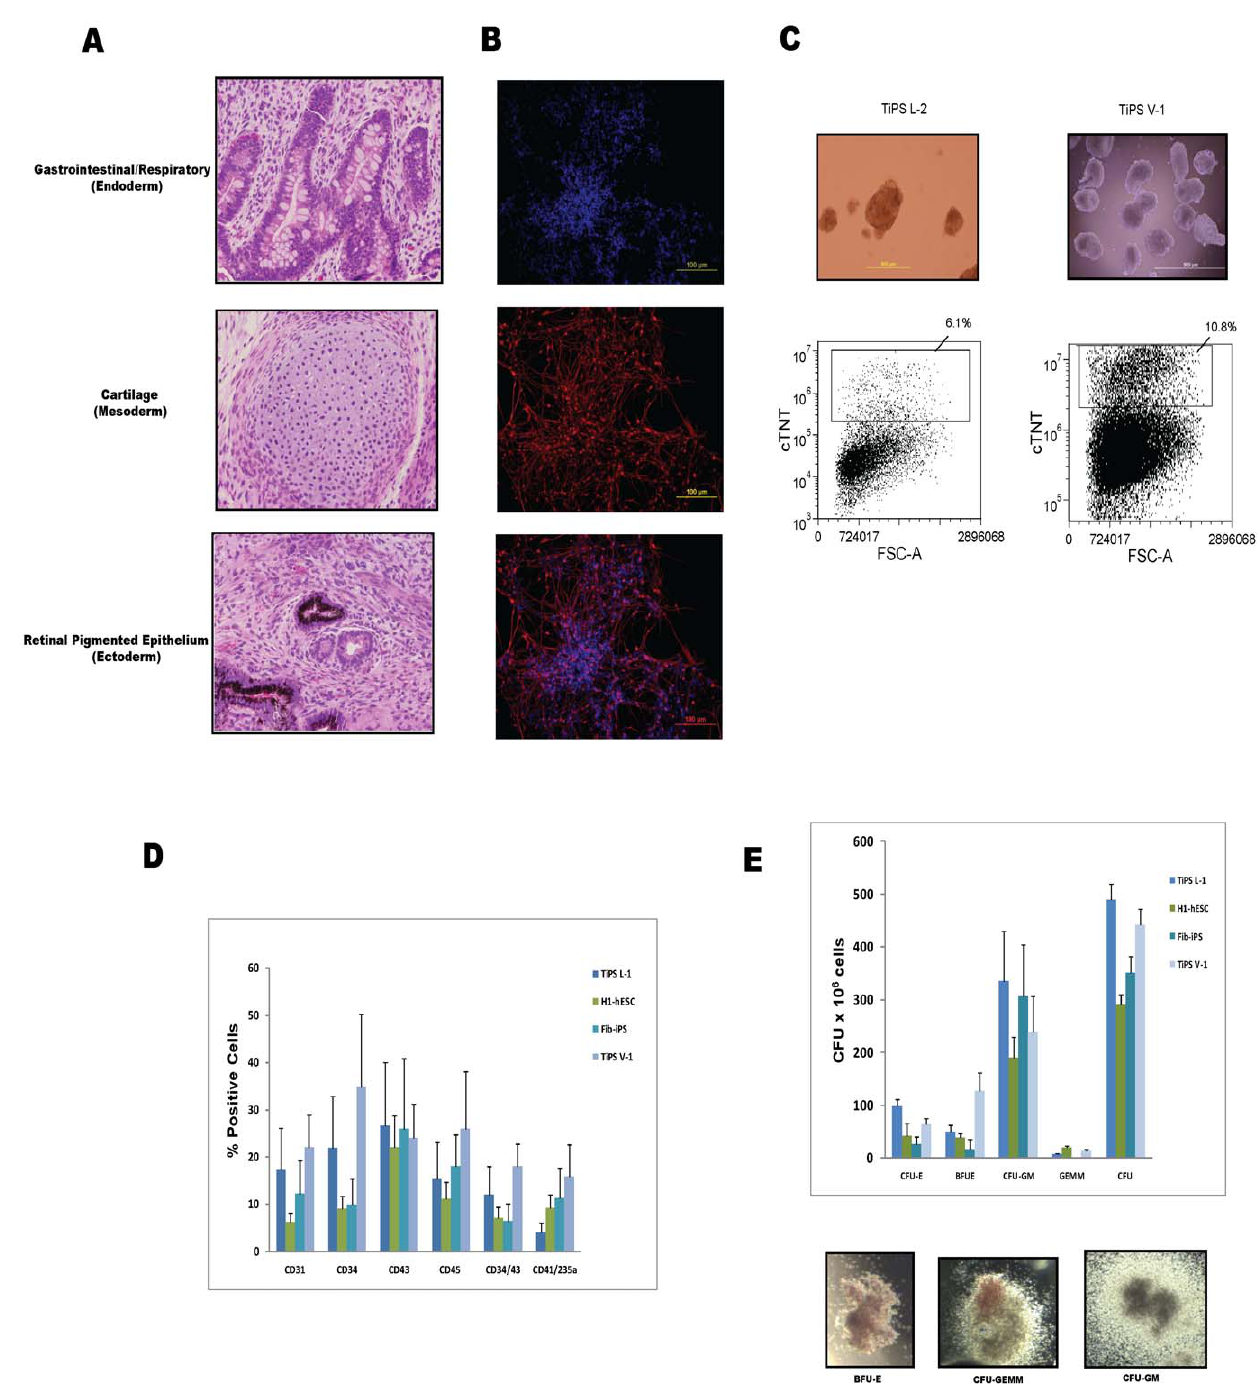
Figure 4. Invivo and invitro differentiation potential of TiPS cell lines. (A) Teratoma formation shows in vivo differentiation potential. TiPS cells injected into SCID/beige mice formed teratomas at 5 to 12 weeks. Hematoxylin and eosin staining shows tissues consistent with derivation from the three primary germ layers including simple epithelium with goblet cells indicating gastrointestinal or respiratory tissue (endoderm), cartilage (mesoderm) and retinal pigmented epithelium (ectoderm). Representative images from TiPS L-2 cell line were acquired using an Olympus IX71 microscope using a 40 6 objective. (B) In vitro differentiation into neurons. TiPS L-2 cells were induced into neuronal differentiation as aggregates then stained for neuronal marker beta III-tubulin with an Alexa Fluor 594 secondary antibody; cell nuclei were counterstained with Hoechst stain. Images were acquired using a 20 6 objective. Contrast was adjusted and images were merged using Image J software. (C) Cardiac induction of TiPS cells via cell aggregate method. Cell aggregates contain beating cardiac troponin T (cTNT)-positive cardiomyocytes at days 14 to 15. Flow data from representative samples is shown. Images were acquired using a 10 6 objective. (D) In vitro differentiation into hematopoietic progenitor cells. Hematopoietic progenitor cells (HPCs) generated via a serum-free embryoid body (EB) differentiation protocol for 12 days in two TiPS lines compared to an hESC line (‘‘H1’’) and a fibroblast derived iPSC line (‘‘Fib-iPS’’). HPCs were quantified via flow cytometry by dissociating the EBs into single cells and staining with fluorochrome-conjugated monoclonal antibodies to CD34, CD45, CD43, CD31, CD41 and CD235a. (E) Hematopoietic clonogenic